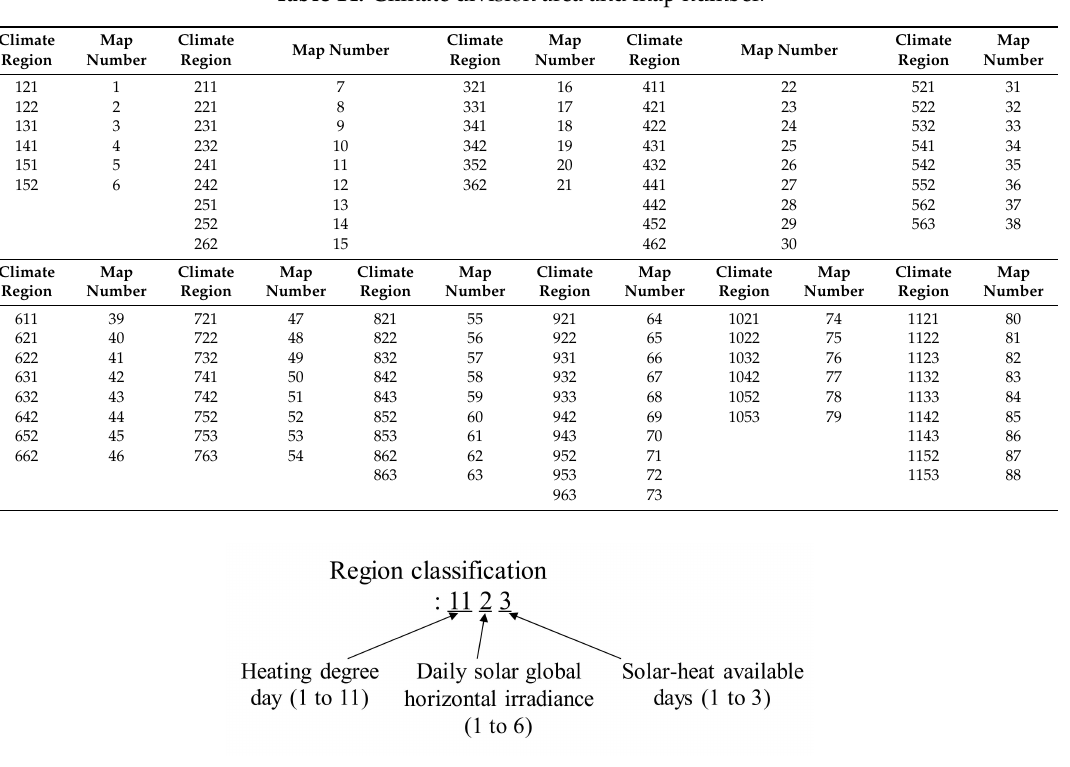
Figure 6. Notation of region